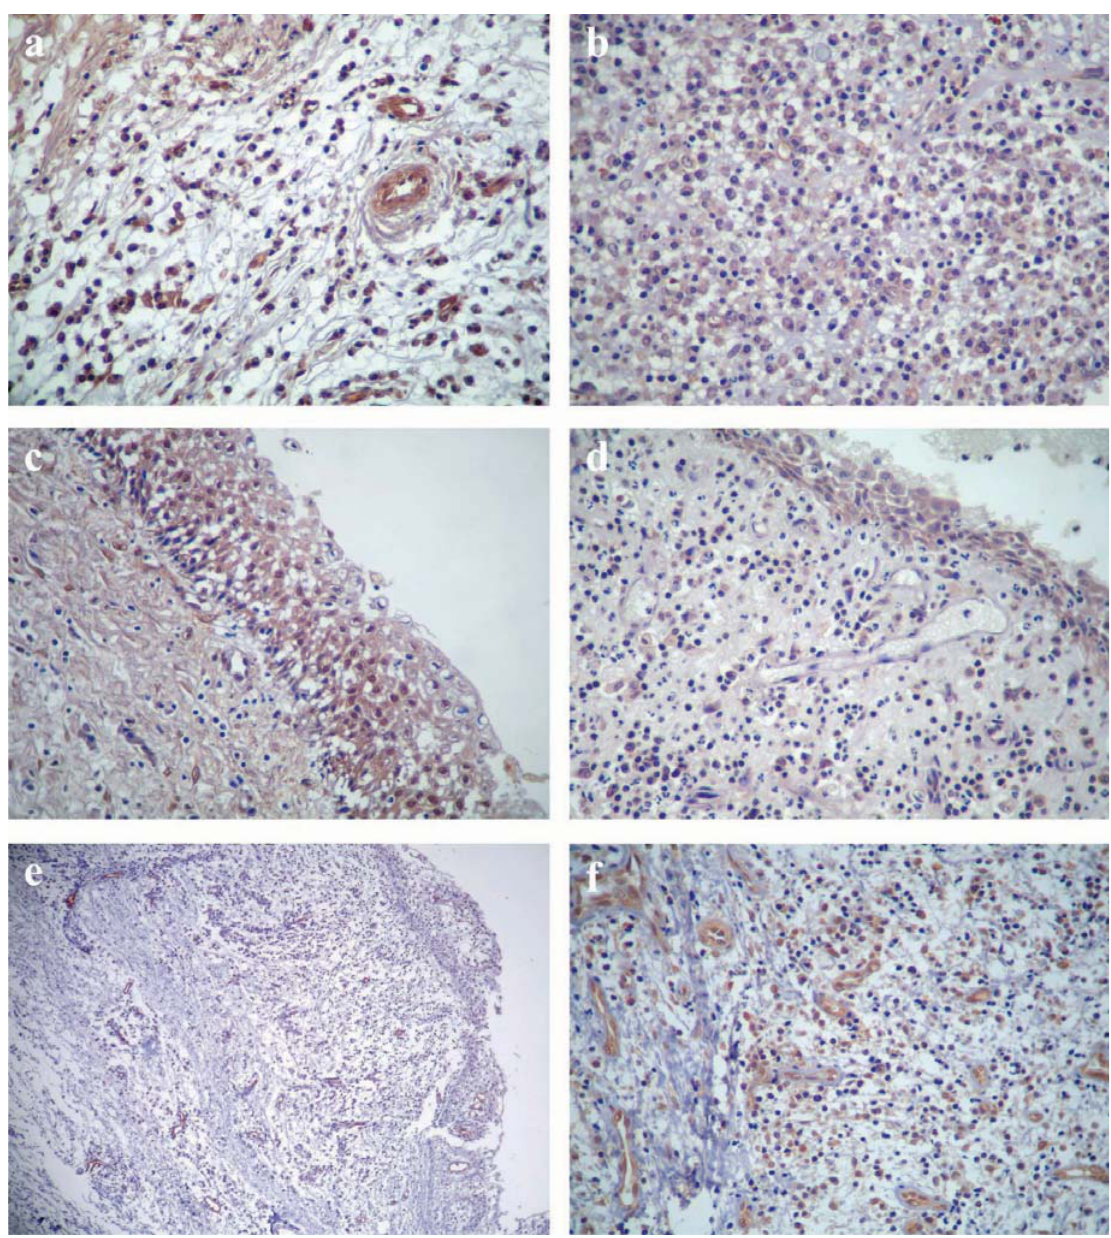
revealed a hyperplastic epithelium in 14 cases (70%) and an atrophic epithelium in 6 cases (30%). In RRCs, 6 cases (60%) presented an atrophic epithelium and 4 cases (40%) showed a hyperplastic